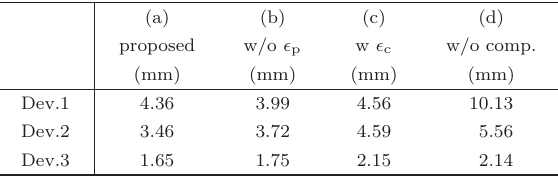
Table 3 Comparison of averaged errors in